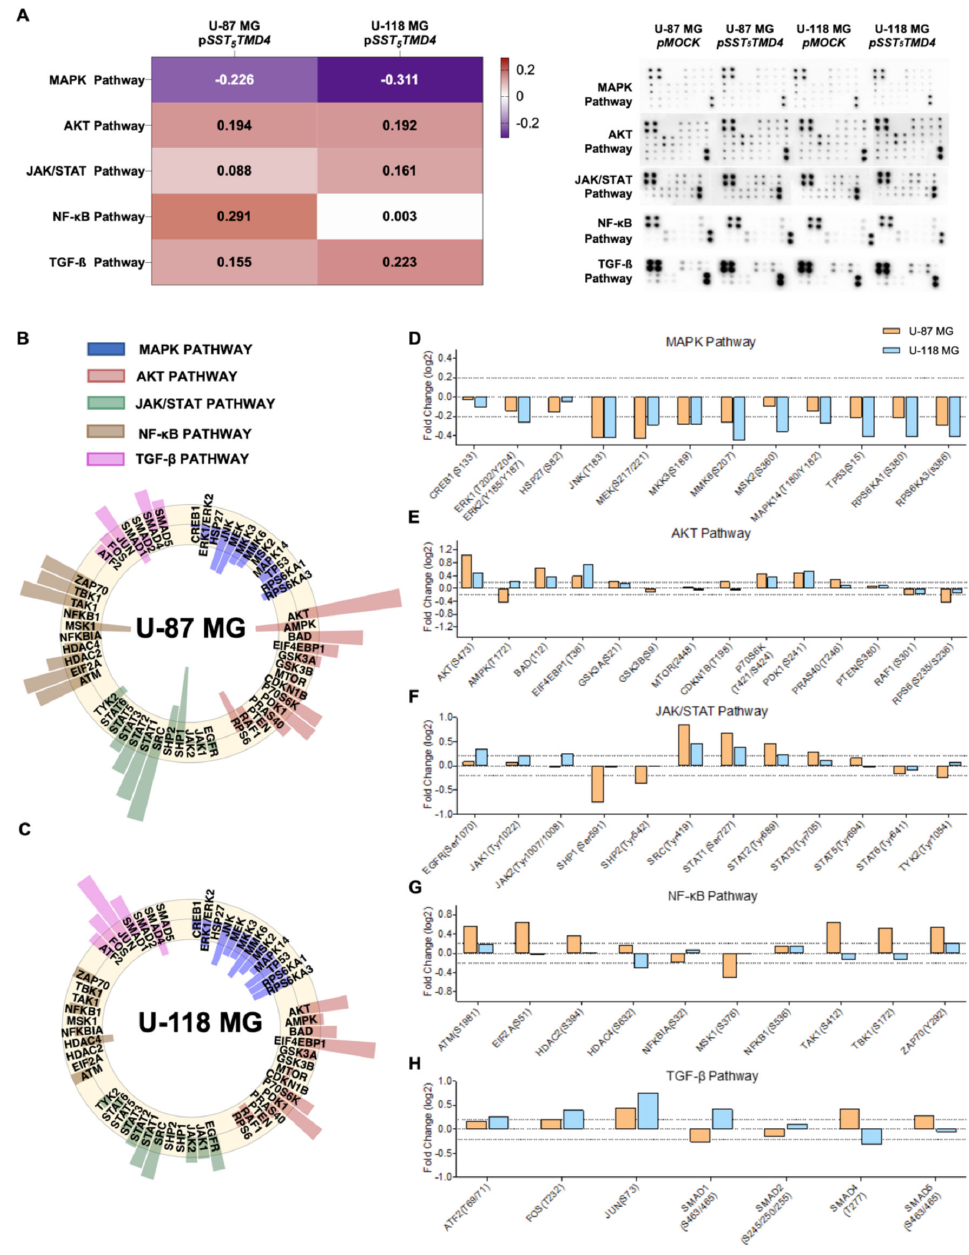
Figure 3. sst5TMD4 overexpression induces phosphorylation of key oncogenic pathway compo- nents in a cell line dependent manner. ( A ) Heatmap showing the logarithm of fold-change mean corresponding to each signaling pathway comparing sst5TMD4 -transfected (overexpression) vs. mock-transfected cells (Left panel); Membranes showing the spots quantified in order to study the phosphorylation level of 55 proteins under different experimental conditions ( sst5TMD4 -transfected vs. mock-transfected cells; Right panel). ( B , C ) Circle plot with Log2 (Fold Change; FC) of each measured protein in the phosphoarray comparing sst5TMD4 -transfected (overexpression) vs. mock- transfected cells [U-87 MG ( B ) and U-118 MG ( C )]. ( D – H ) Individual phosphorylation protein level after sst5TMD4 overexpression vs. the control condition in both GBM cell lines [threshold: log2 (FC) = ± 0.2; pointed